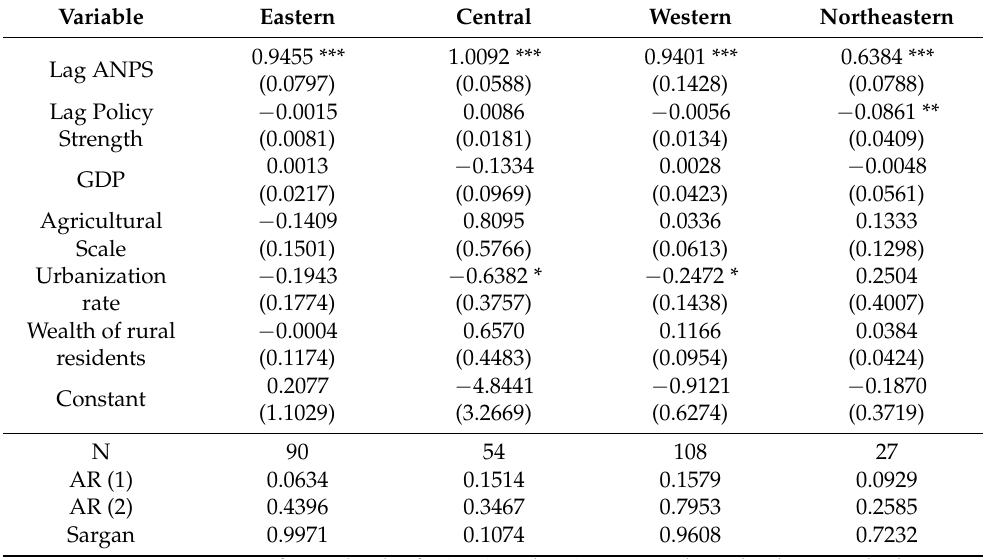
Table 6. Regression results of policy effects on ANPS pollution in different